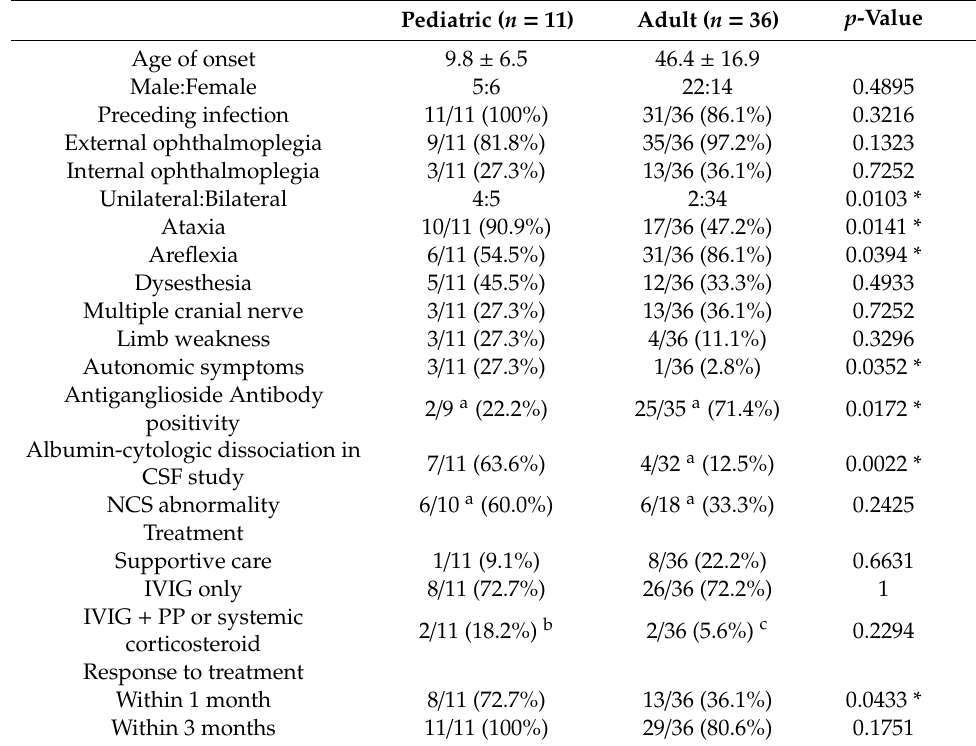
Table 2. Comparison between pediatric and adult Miller Fisher syndrome.